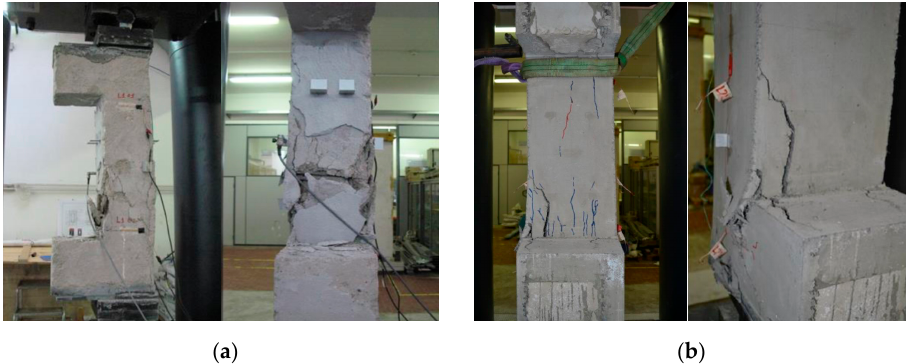
Figure 8. General views (frontal or lateral) and details of the final damage states for the specimen U1 ( a ) and S1 ( b ).